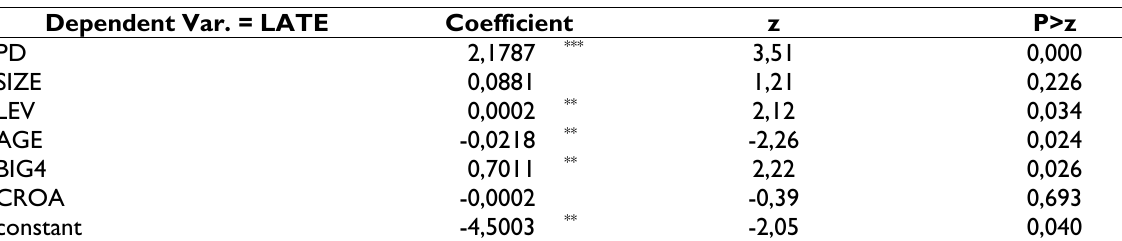
Table 4. The Effect of Financial Distress on Reporting Delay Dependent Var. =